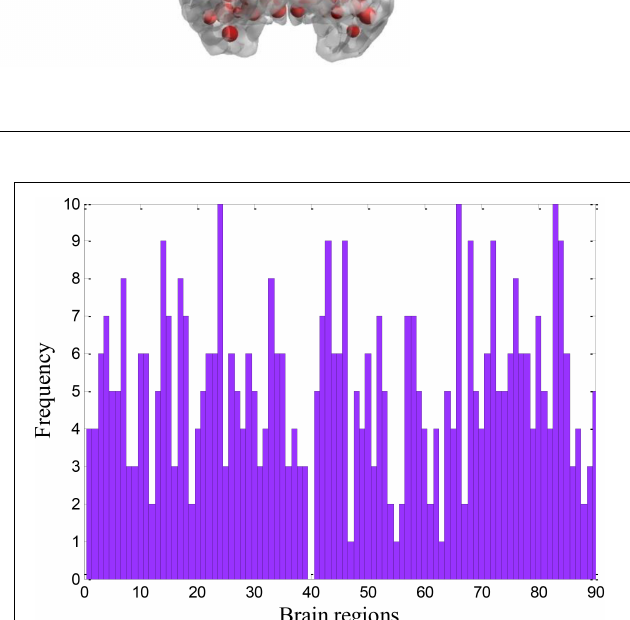
FIGURE 6 | The accuracy of the random SVM cluster with different candidate set of optimal features.